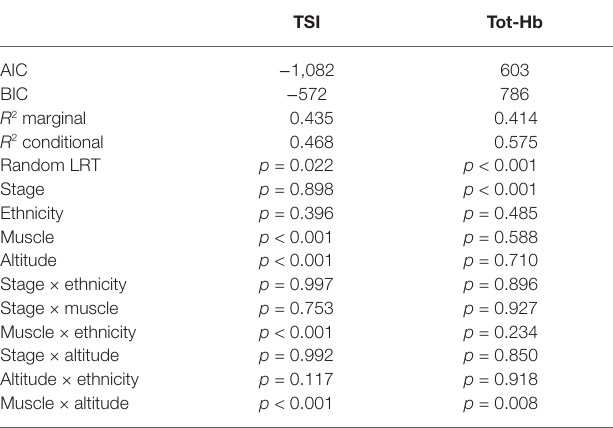
TABLE 2 | General Linear Mixed Model (GLMM) statistics of NIRS parameters; stage, ethnicity, muscle and altitude: fixed factors; participants: random factor.